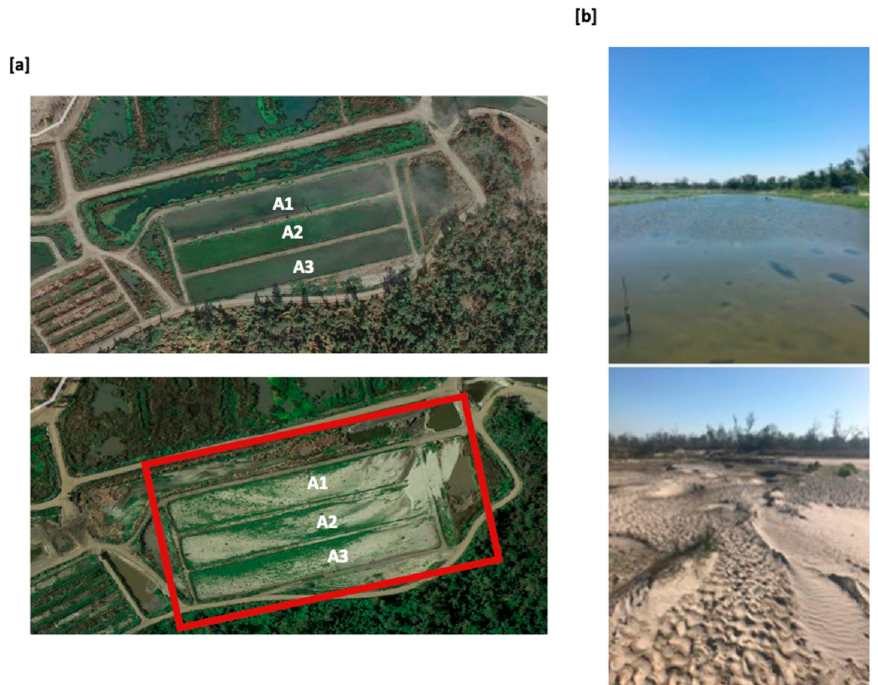
Figure 1. ( a ) Prado Wetlands demonstration scale unit process open water (UPOW) wetland (Big Bubbs) before (top, Google Earth, taken 12 December 2017) and (bottom) after the 19 February 2019 flooding event (imagery from Google Earth, taken 2 May 2019). This image depicts the introduction of sands and other inorganic sediments and the flowpath of the flooding event. ( b ) (top) A fully functional demonstration scale UPOW wetland (Cell A3) at Prado Wetlands during normal operating conditions (taken summer 2018) and (bottom) following flow shut-off after the flood event and the resulting sediment intrusion (taken March